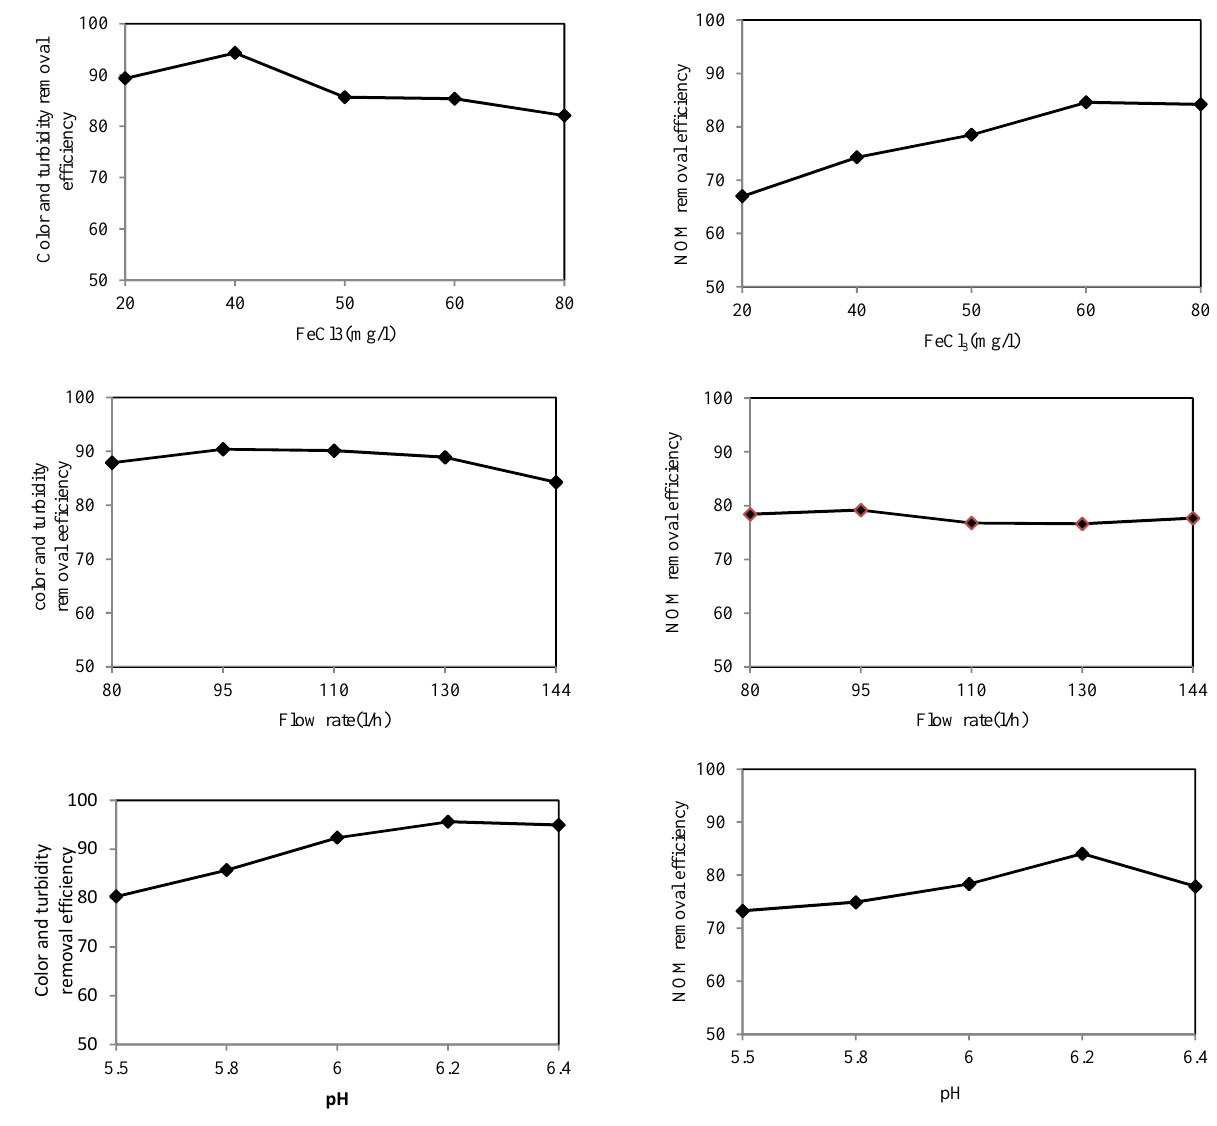
Fig. 3.The effect of changes pH, coagulant dose of Ferric chloride and influent flow on the color, turbidity and NOM removal